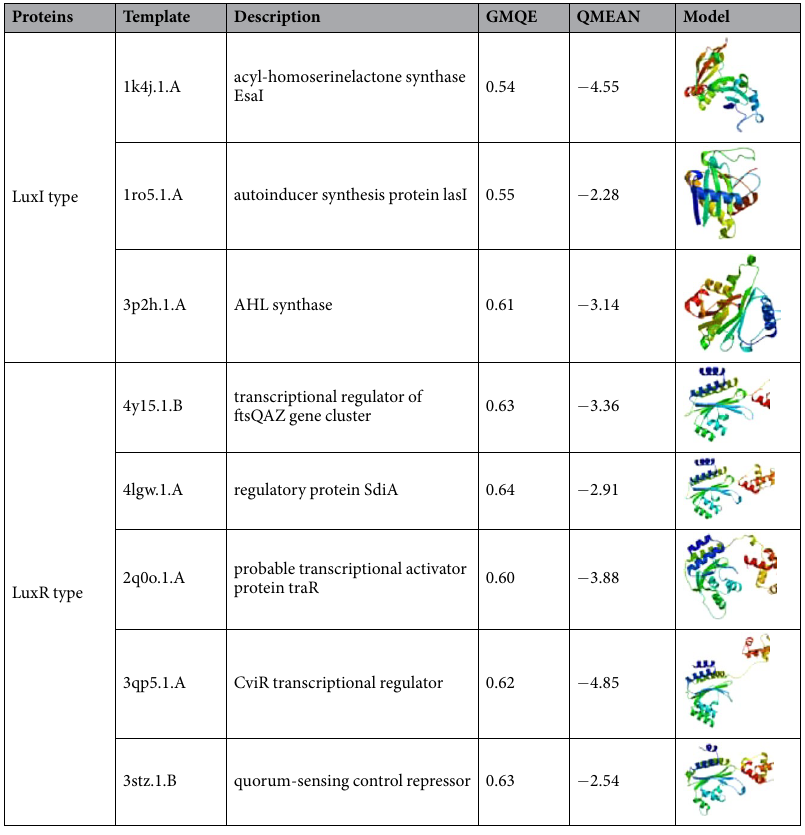
Table 3. Structures and scores of LuxI and LuxR type proteins models of A. sobria